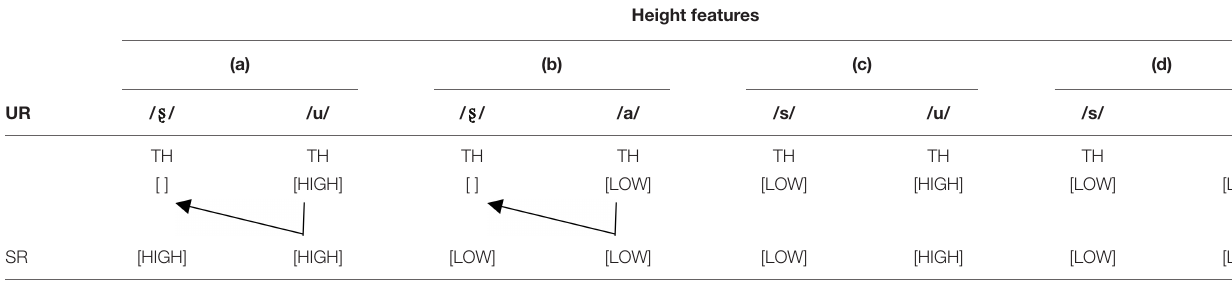
TABLE 3 | The spreading of HEIGHT features from vowel to consonant.